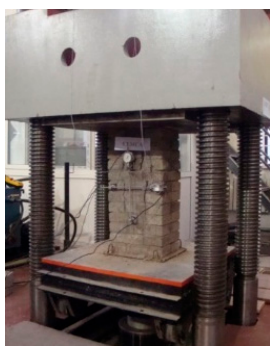
Figure 7. The test loading of the compressive specimen.